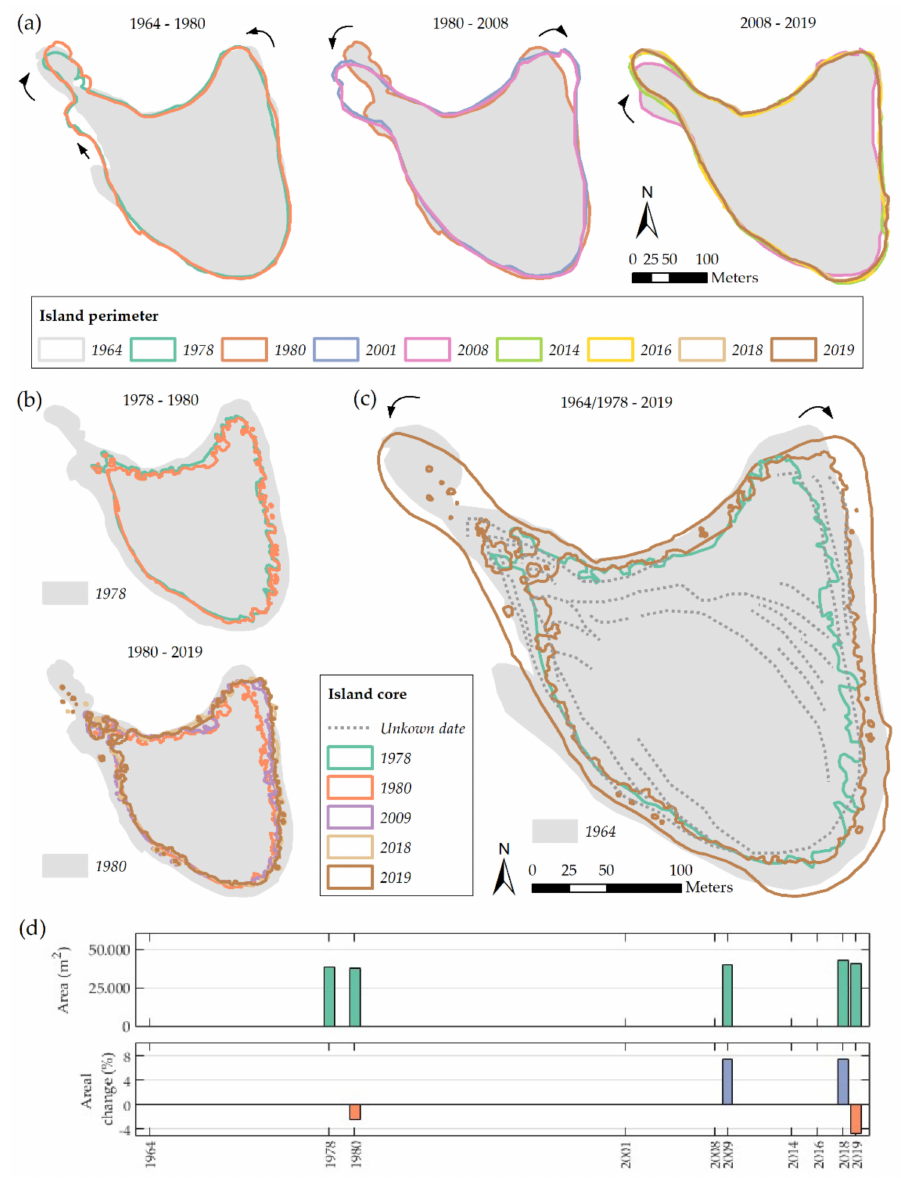
Figure 6. Planform geomorphic changes and evolution of ( a ) the island perimeter/shape (1964–2019) and ( b ) island vegetation line/core (1978–2019), where the black arrows indicate the direction of the planform changes. ( c ) Net changes in the island perimeter between 1964 and 2019 (grey hatch and brown outer line), and net changes in the vegetated core between 1978 and 2019 (green and brown inner lines), and ( d ) OTI vegetated core areal changes (in m 2 and in % change, where green represents the measured areas (Table 4), and blue and red represent gross increase and decrease in size, respectively). Dotted lines represent the possible location of previous shorelines inferred from the high-resolution LiDAR captured in